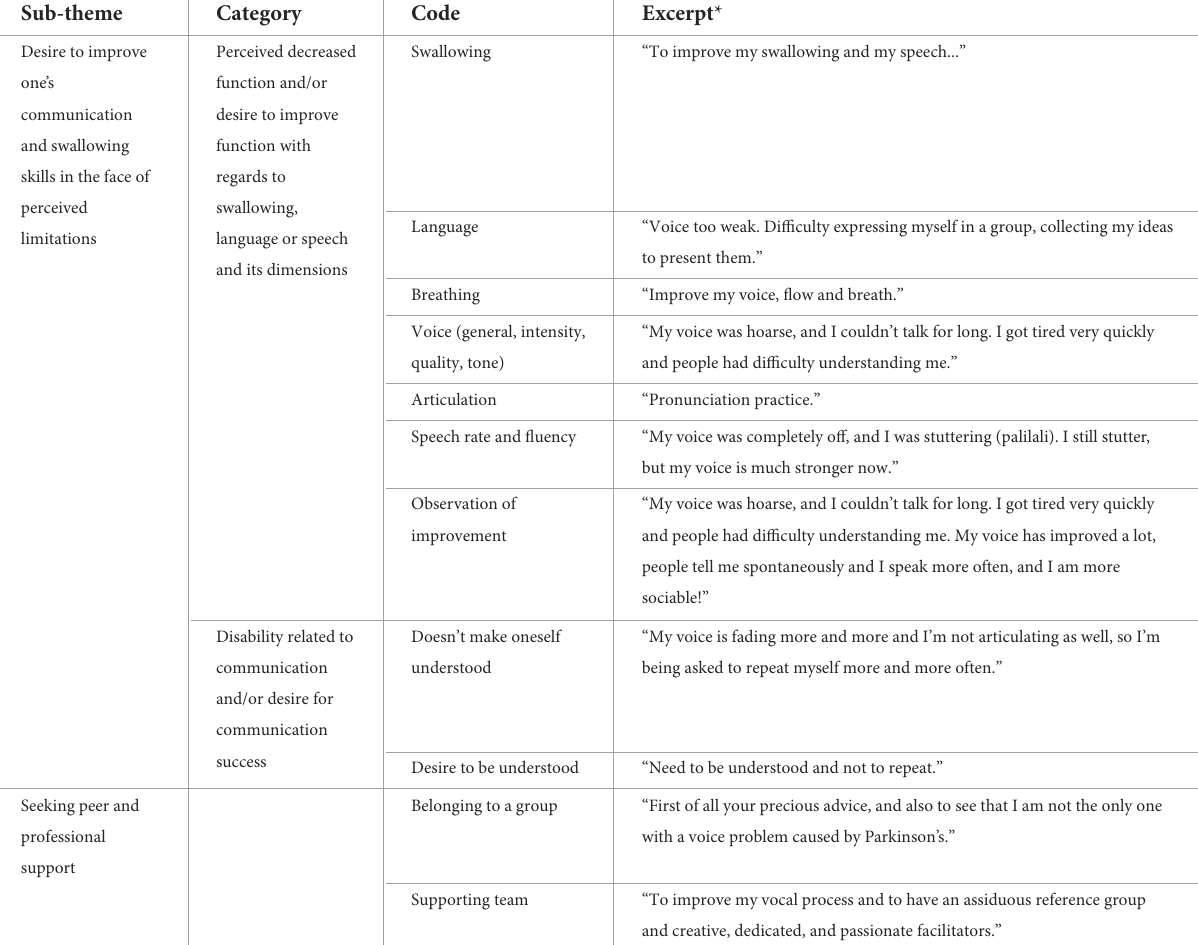
TABLE 3 Seeking improvement and support as initial motivations to engage in